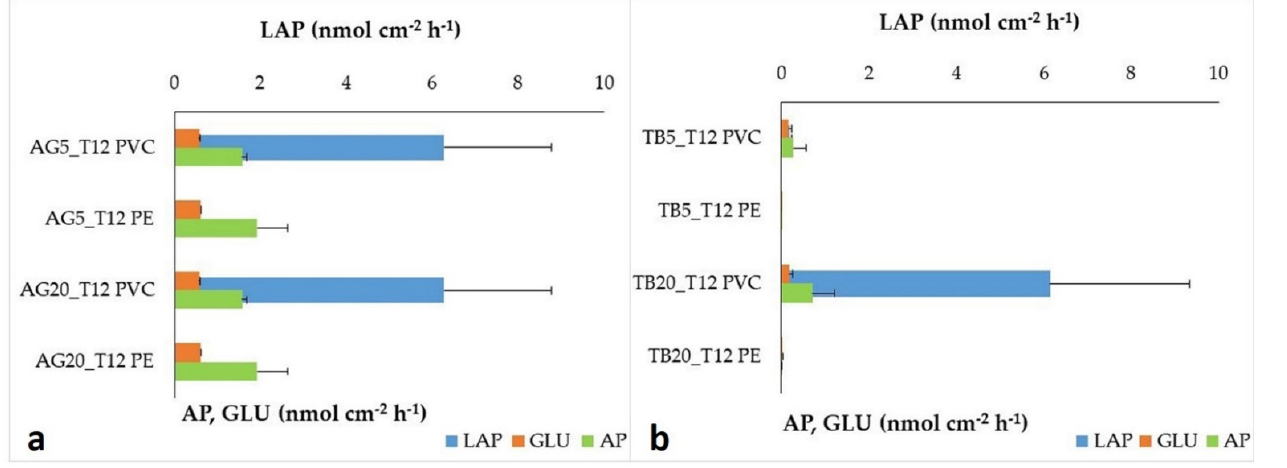
Figure 6. Mean values + standard deviations of enzymatic activity rates (Leucine aminopeptidase, LAP; beta-glucosidase, GLU; alkaline phosphatase, AP) measured in the microbial biofilm developed on plastic materials submerged in the Tethys Bay area at 5 m and 20 m for 12 months (T12). ( a ) AG, Amorphous Glacier (impact station); ( b ), TB, Tethys Bay (control station). PVC: Polyvinyl chloride; PE: Polyethylene.